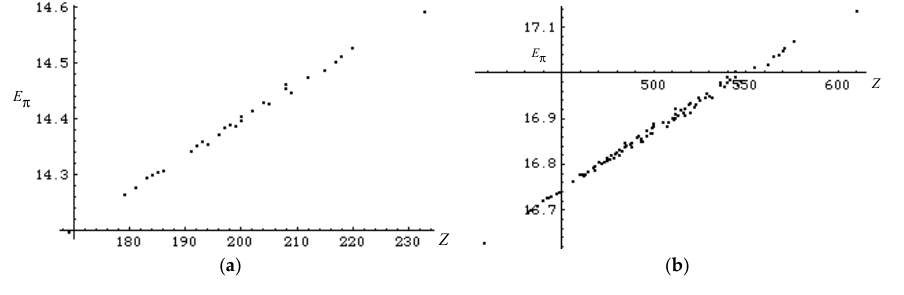
Figure 3. Correlation between Z and E π for isomers of ( a ) 30 dodecahexaenes and ( b ) 96 tetradecaheptaenes.